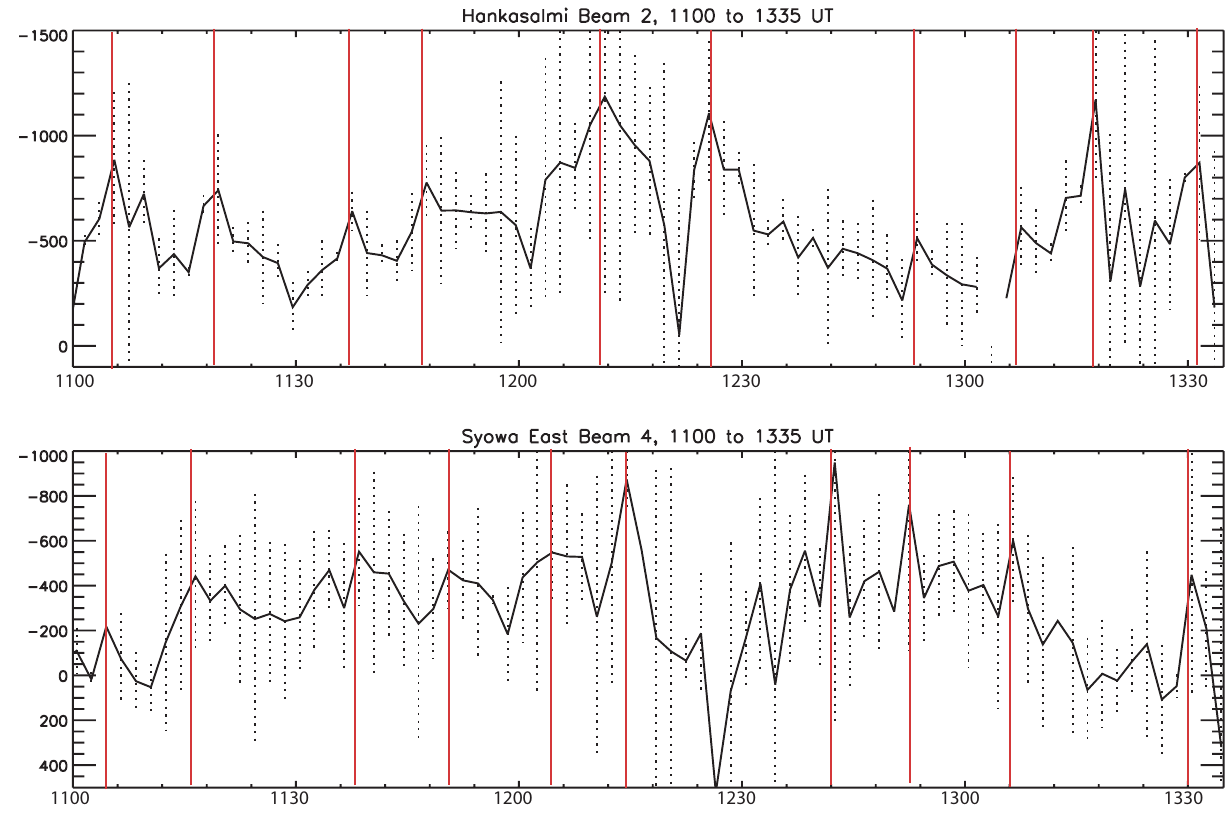
Fig. 10. The top panel presents the average l-o-s velocity observed at six ranges between magnetic latitude 76 ◦ to 80 ◦ for beam 2 of the Hanksalmi radar. The bottom panel shows the averaged velocity observed at selected ranges between latitudes − 76 ◦ to − 82 ◦ for beam 4 of the Syowa East radar. The dashed black lines are the standard deviation of the average velocity. Solid red lines highlight selected flow